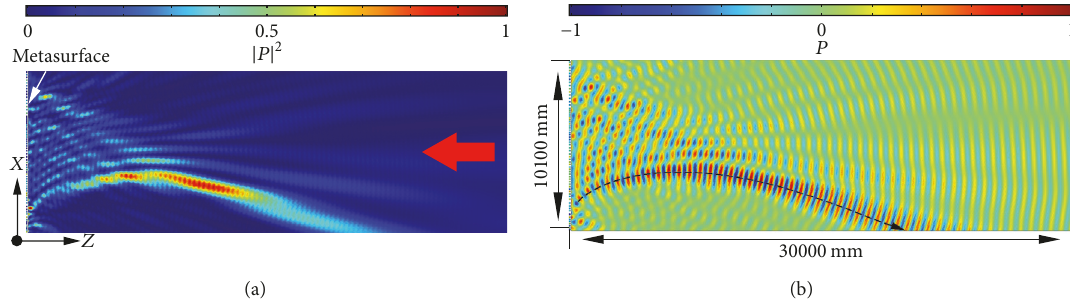
Figure 6: Acoustic nondiffracting Airy beam. (a) The squared absolute pressure field of reflected waves. The red arrows represent the propagation direction of incident plane wave. (b) The transient pressure field distribution of reflected waves. The black dashed arrow indicates the travel trajectory of the acoustic